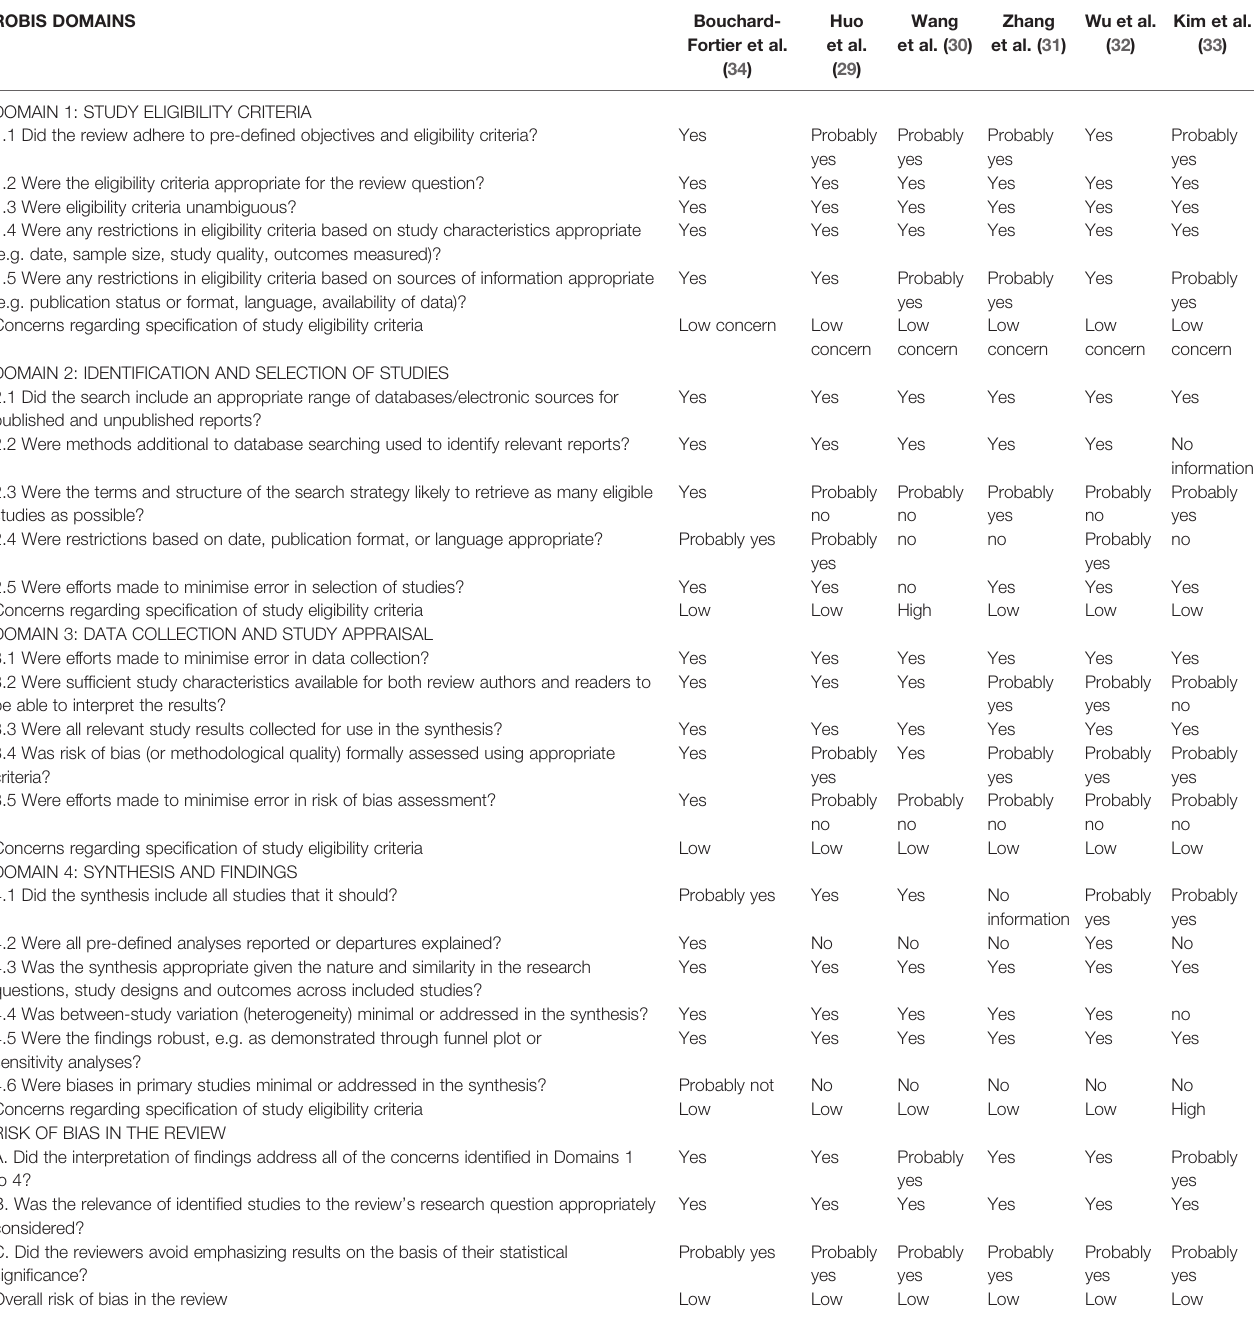
TABLE 3 | Risk of bias